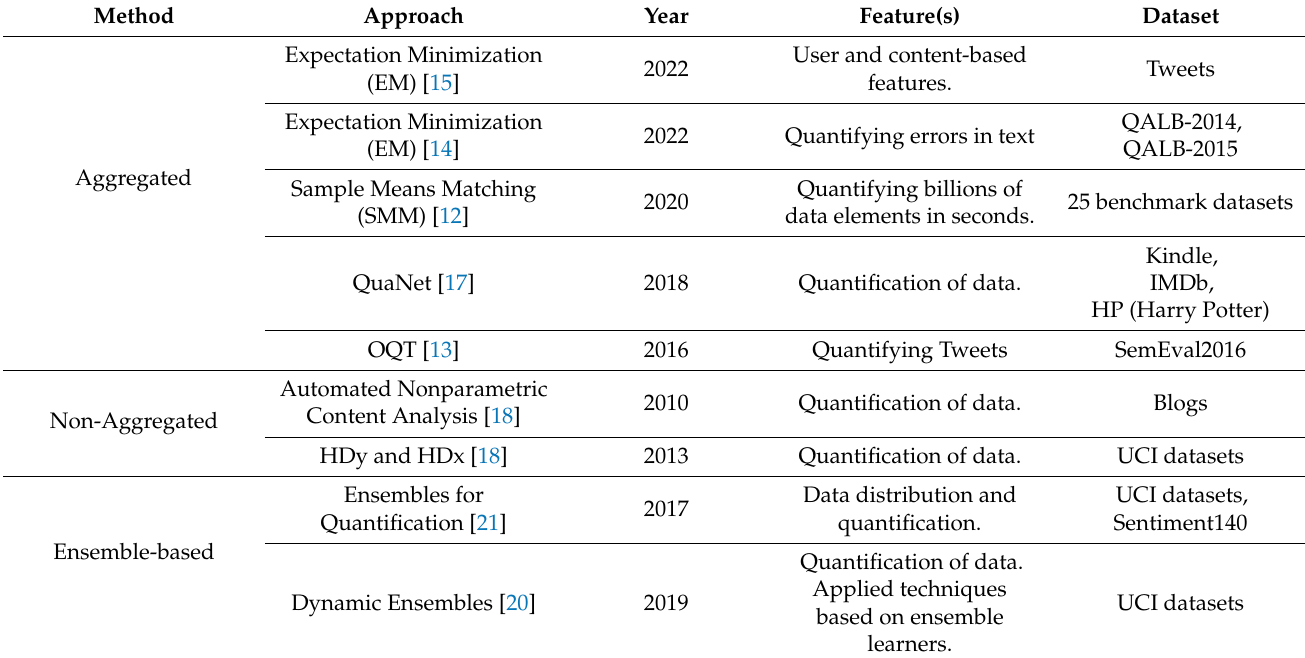
Table 1. Quantification